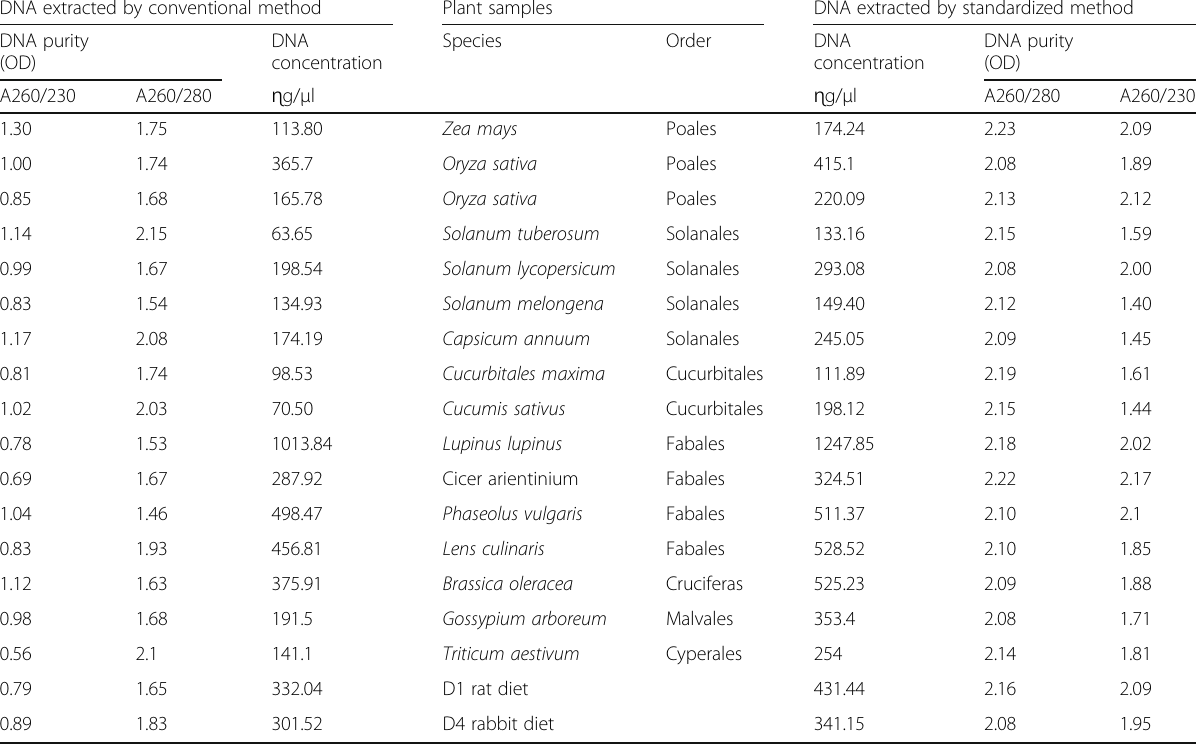
Table 2 Purity and concentration of DNA extracted by classical and standardized methods from 15 plant species representing seven plant orders DNA extracted by conventional method Plant samples DNA extracted by standardized method DNA purity DNA (OD) concentration